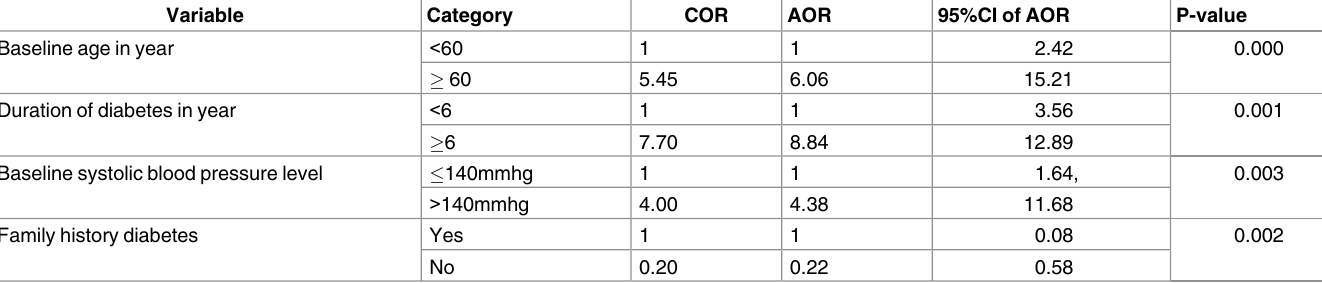
Table 3. Adjusted binary logistic regression analysis of diabetic patients at Arbaminch general hospital, 2015/16, (n = 270).